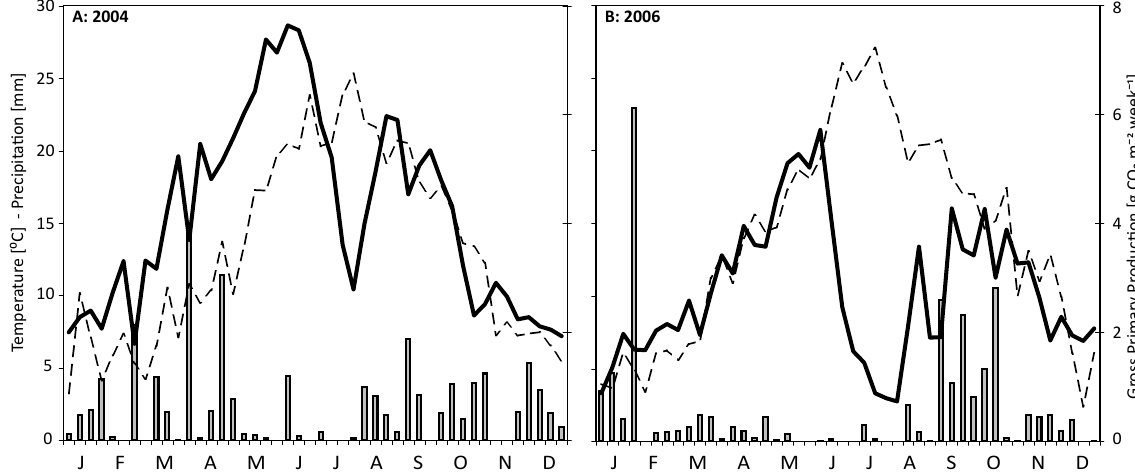
Fig. 9. Weekly ecosystem gross productivity (black line), average temperatures (dotted line), and precipitation (bars), derived from flux measurements at Puechabon CarboEuropeIP test